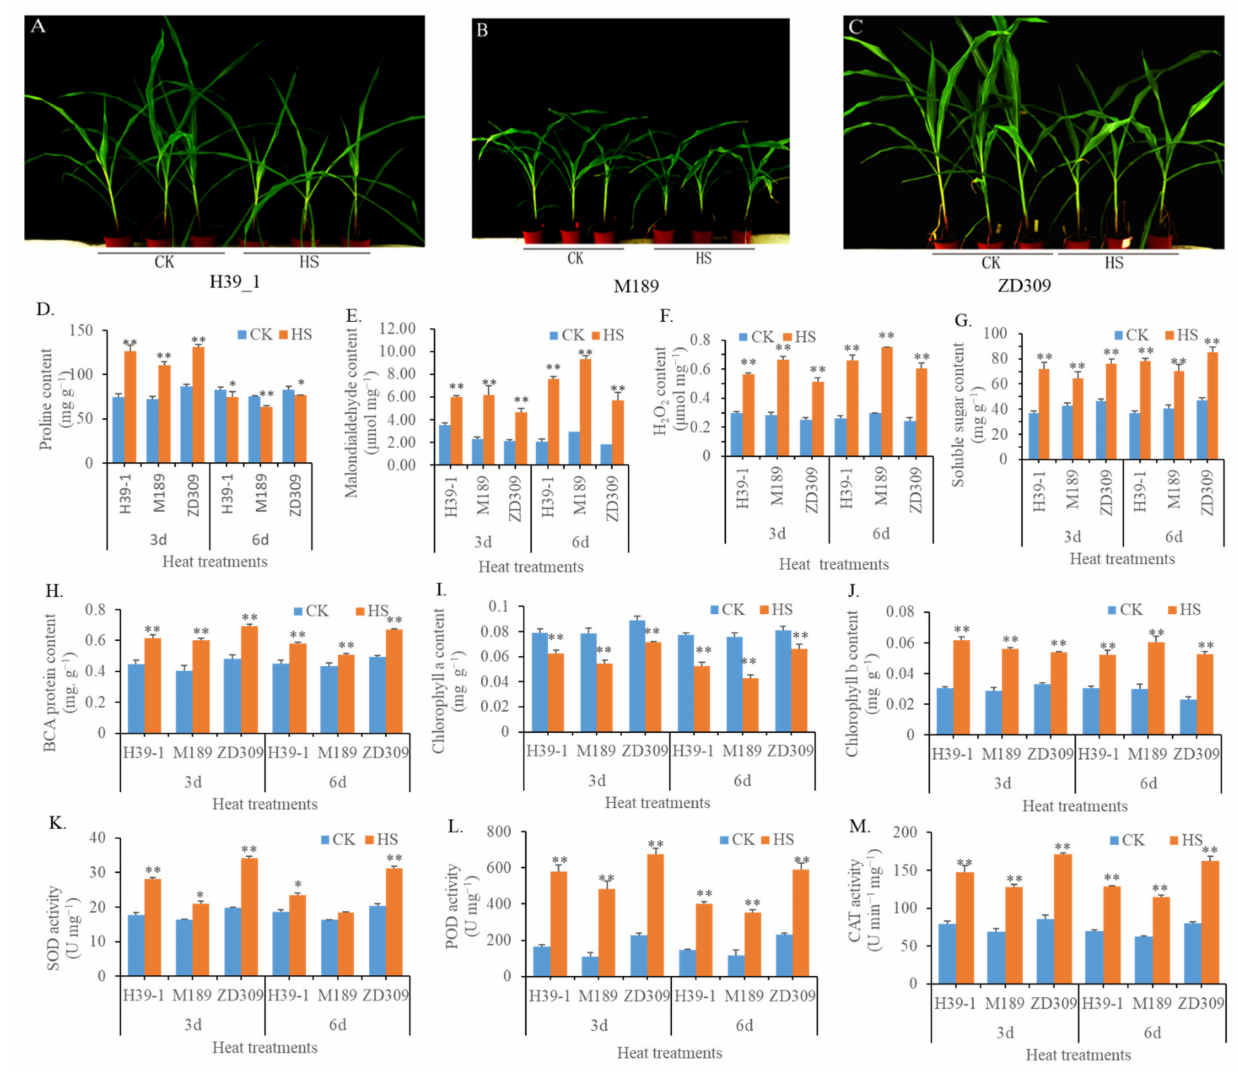
Figure 1. The effects of heat stress on maize growth and physical characters in ZD309 and its parental lines. ( A – C ) Performance of maize plants treated by 6 days heat stress in H39_1 (( A ), maternal line), M189 (( B ), paternal line), and ZD309 ( C ); ( D – M ) Physical alterations mediated by heat treatments, including proline content ( D ), malondialdehyde content ( E ), H 2 O 2 ( F ), soluble sugar ( G ), BCA protein ( H ), chlorophyll a/b content ( I , J ), as well as SOD, POD, and CAT activity. For the content of proline, soluble sugar content, BCA protein, chlorophyll a/b, the measurement unit, mg g − 1 , represents the respective content in 1 g of sample’s fresh weight; For the content of malondialdehyde and H 2 O 2 , the measurement unit, µ mol mg − 1 , represents the respective content in 1 mg of sample’s fresh weight; For the activity of SOD and POD, the measurement unit, U mg − 1 , represents the respective activity units detected in 1 mg of sample’s fresh weight; For CAT activity, the measurement unit, U min − 1 mg − 1 , 1 activity unit (U) represents the A240 absorbance decreased 0.1 OD in 1 min and 1 mg of sample’s fresh weight. * and ** represent that the corresponding physical character in heat-stressed maize plants are significantly and very significantly different from the control at p < 0.05 and p < 0.01 levels,